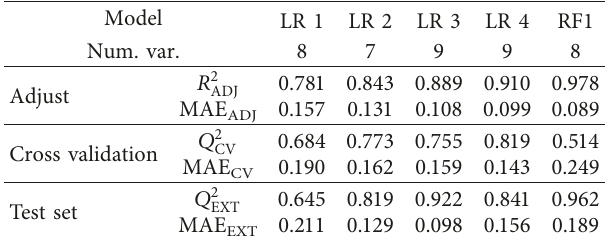
Table 1: The five most robust models based on regression co- efficients and MAE values for adjusting, cross validation, and test set estimated by using Weka